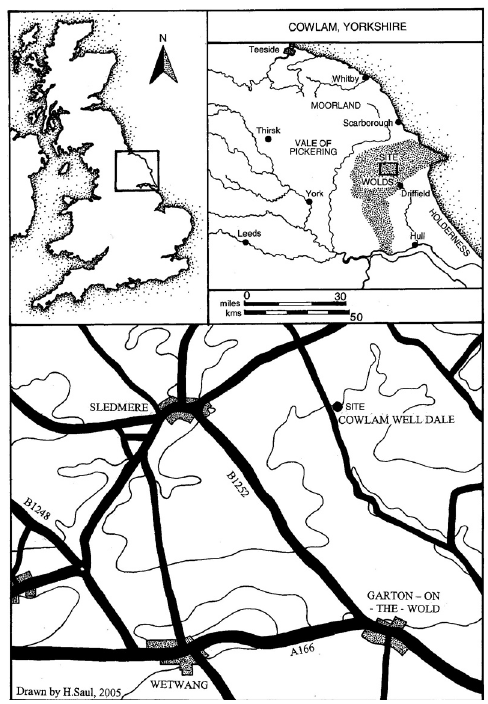
Figure 1. Location Plan. Image courtesy of Haylet